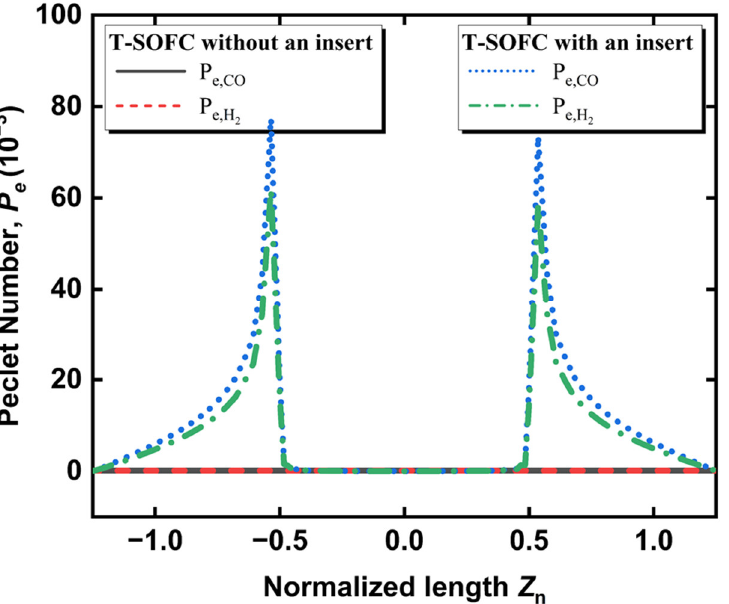
Figure 8. The axial distribution of Péclet numbers at the anode/channel interface in the tubular SOFCs with and without inserts.